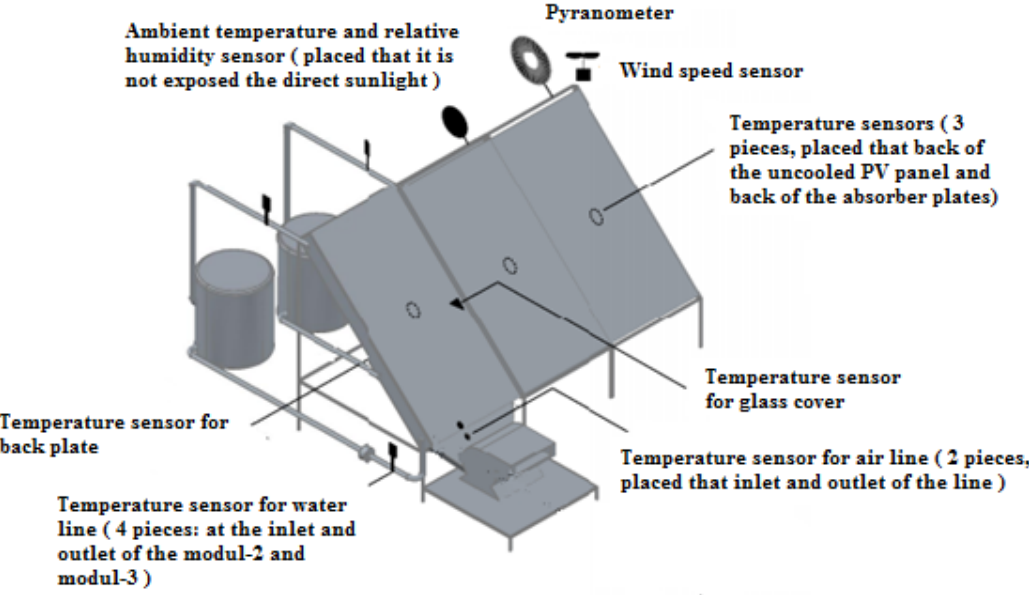
Figure 4. Placement of sensors.